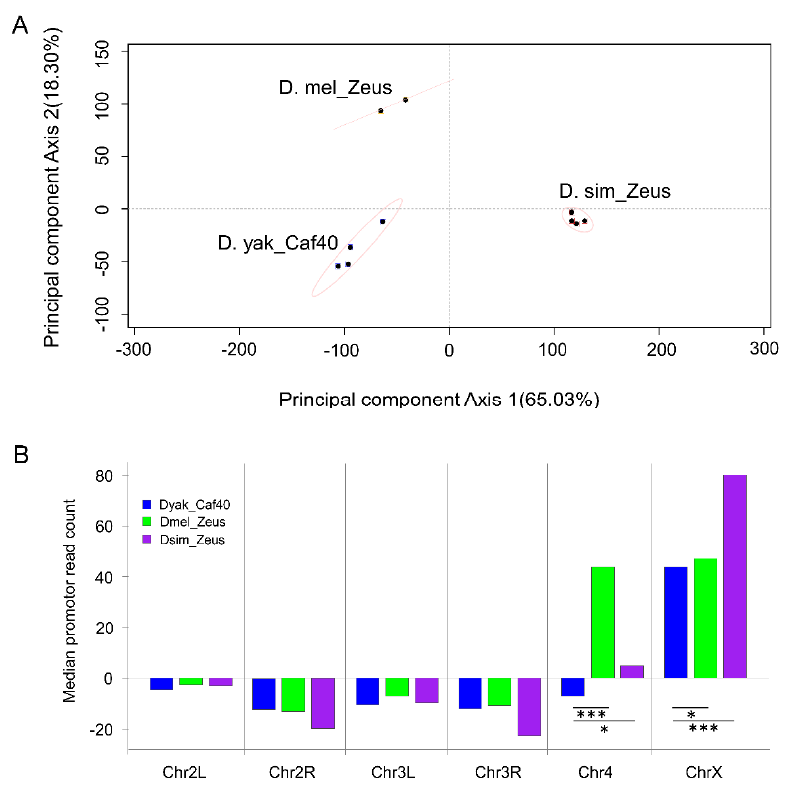
Figure 2. Evolution of Zeus binding affinity in trans. ( A ) Graph of the first two principal components of ChIP-Seq read counts revealed reproducible clustering of replicates of the same protein, while different proteins showed differentiation. ( B ) Bar plot showing the median normalized read counts over TSSs for each chromosome, indicating differences in chromosome-level affinity of the three proteins. Both copies of Zeus show increased affinity relative to Caf40 on chromosomes X and 4, albeit to different degrees. t -test: * p < 0.05, *** p < 0.001. Error bars indicate